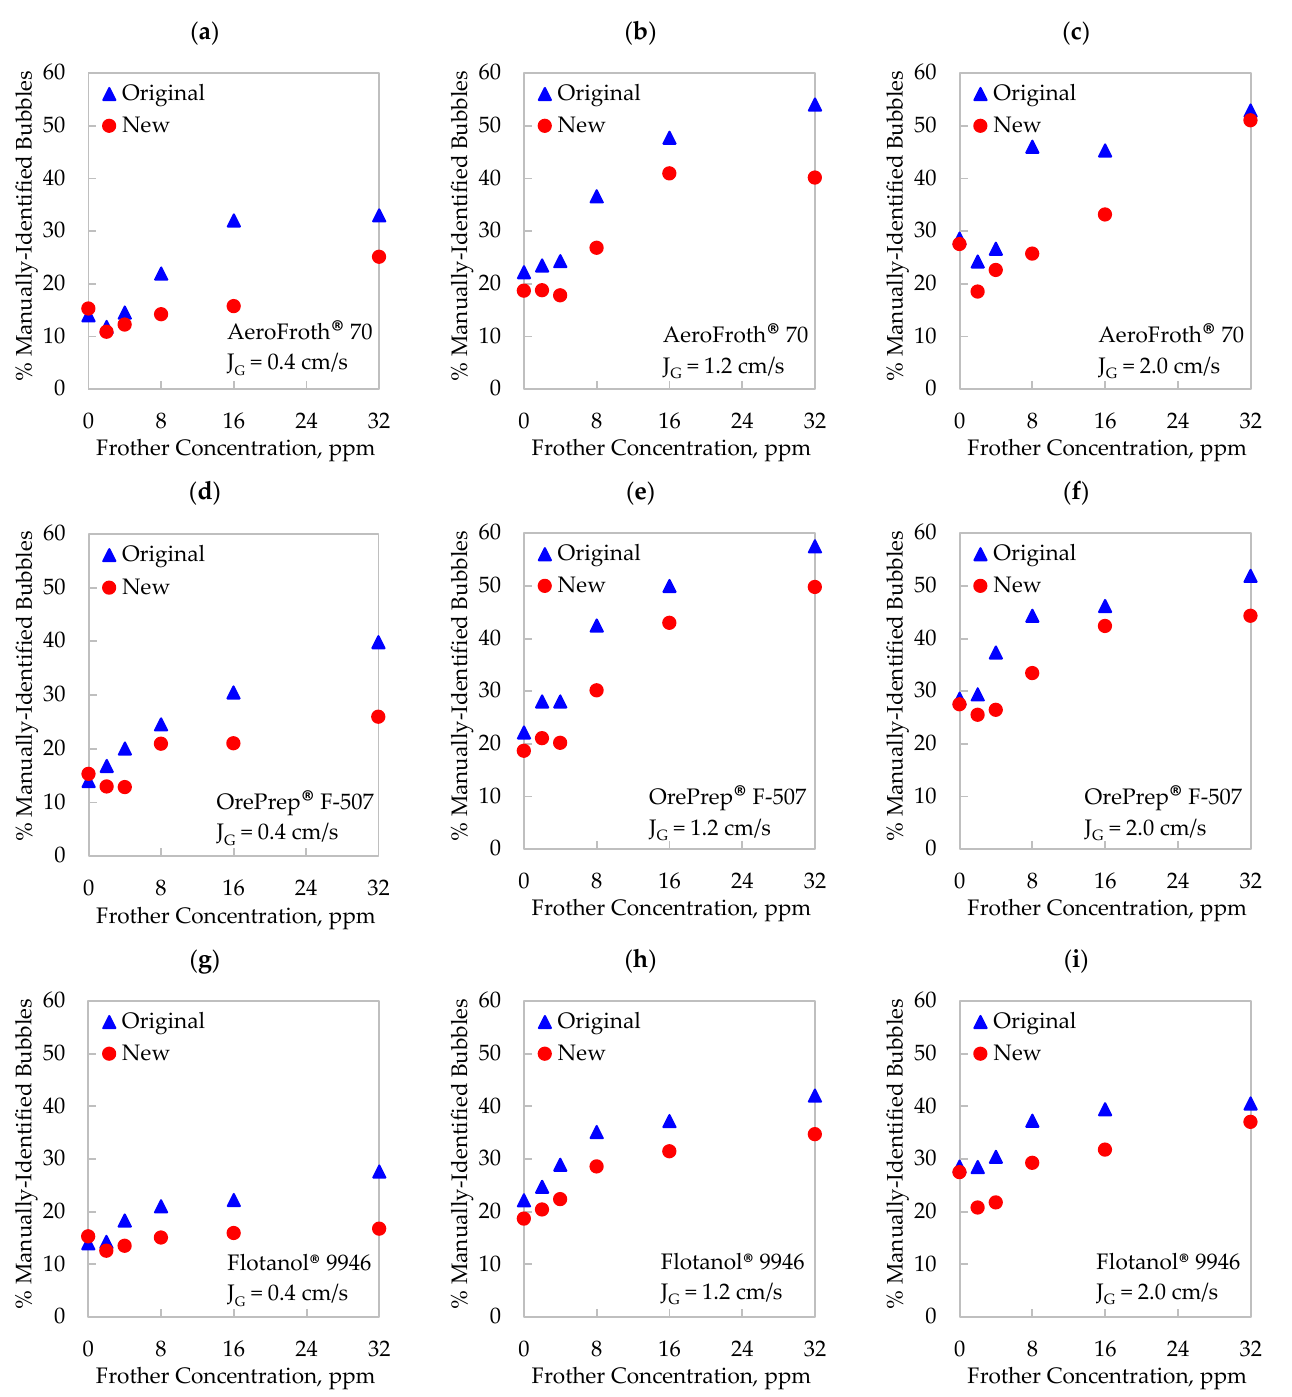
Figure 4. Comparison of the percentages of bubbles that were manually identified when using the original and the new deflectors. Operating conditions: AeroFroth ® 70, ( a ) J G = 0.4 cm/s, ( b ) J G = 1.2 cm/s, ( c ) J G = 2.0 cm/s; OrePrep ® F-570, ( d ) J G = 0.4 cm/s, ( e ) J G = 1.2 cm/s, ( f ) J G = 2.0 cm/s; Flotanol ® 9946, ( g ) J G = 0.4 cm/s, ( h ) J G = 1.2 cm/s, ( i ) J G = 2.0 cm/s. Figure 5 illustrates the percentages of bubbles observed in clusters at a 4 ppm frother concentration when using the original and new deflectors in the bubble sampling. The